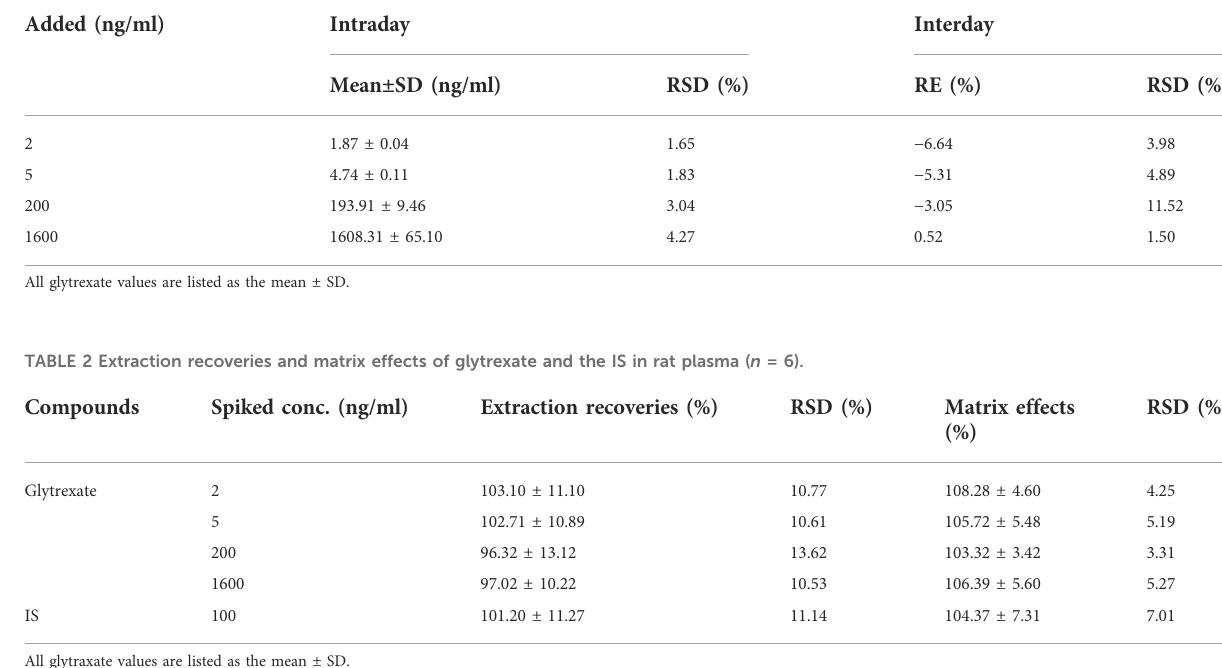
All glytraxate values are listed as the mean ± SD.